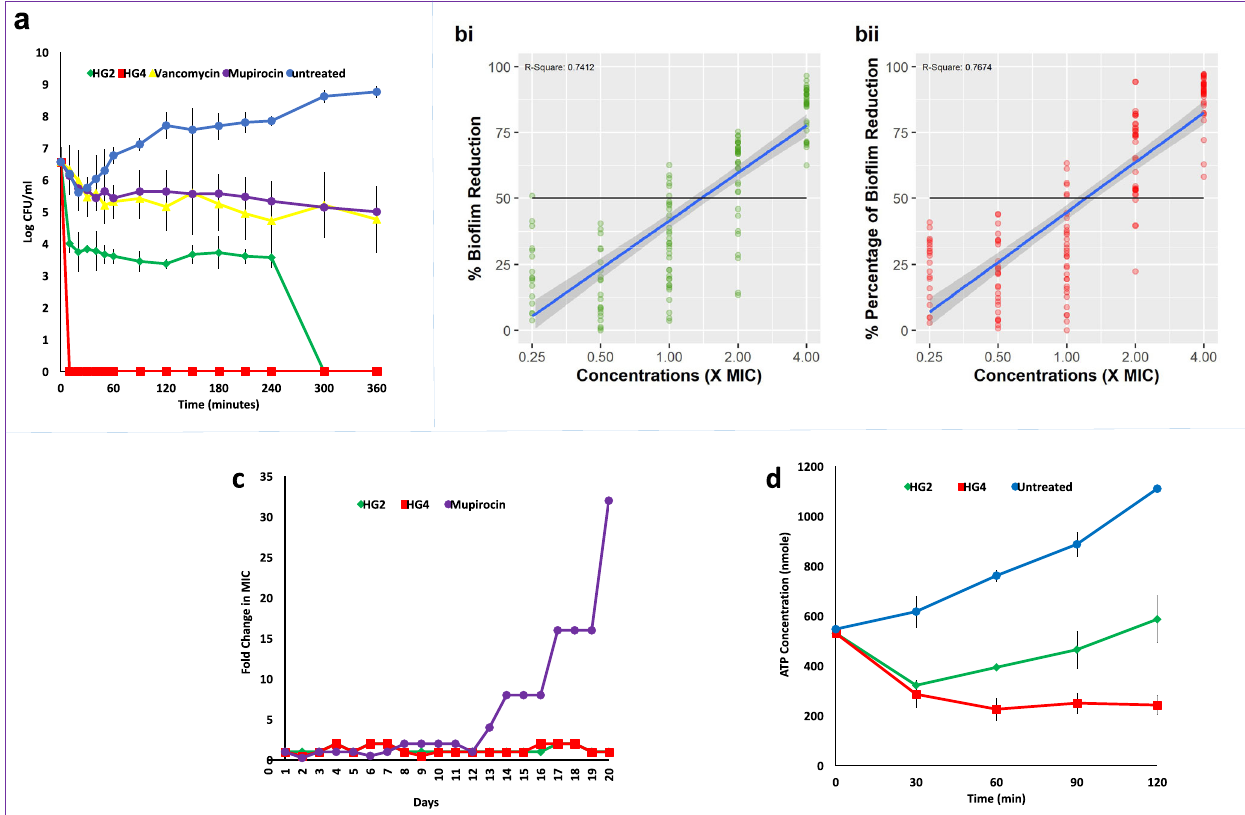
Fig. 3 Antimicrobial susceptibility and activity of HG2 and HG4. a Time-dependent kill of MRSA USA300 cells by AMPs and comparator antibiotics at 3x MIC concentration. bi Anti-bio fi lm activity of HG2 against MRSA USA300 bio fi lms and bii Anti-bio fi lm activity of HG4